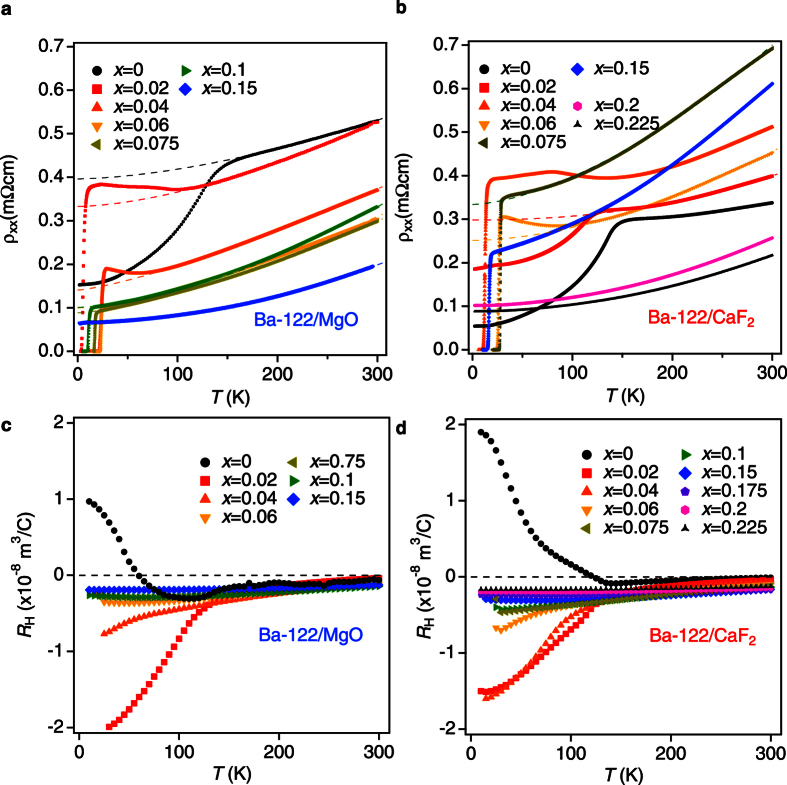
Transport properties of Ba-122/MgO and Ba-122/CaF2 thin films.Resistivity data for Ba(Fe1−xCox)2As2 thin films on (a) MgO and (b) CaF2 substrates. Broken lines are the fitting curves using ρ = ρ0 + ATn in the paramagnetic (PM) state. Hall coefficient of Ba(Fe1−xCox)2As2 films on (c) MgO and (d) CaF2 substrates as a function of temperature.